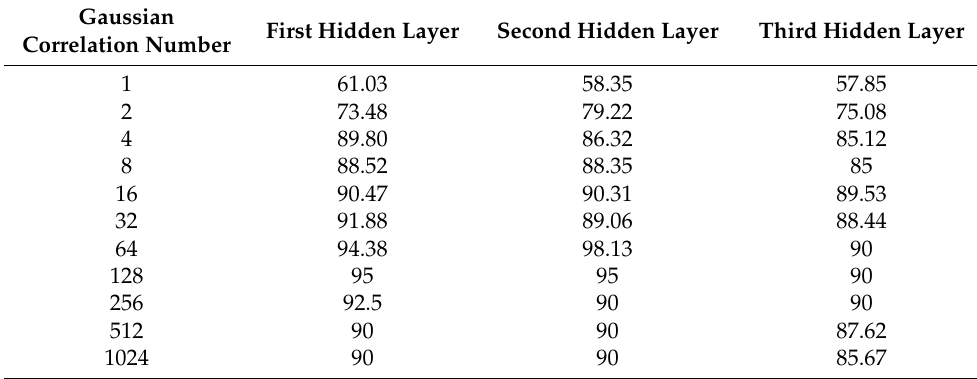
Table 1. Speaker recognition rate with bottleneck layer at different positions (%).